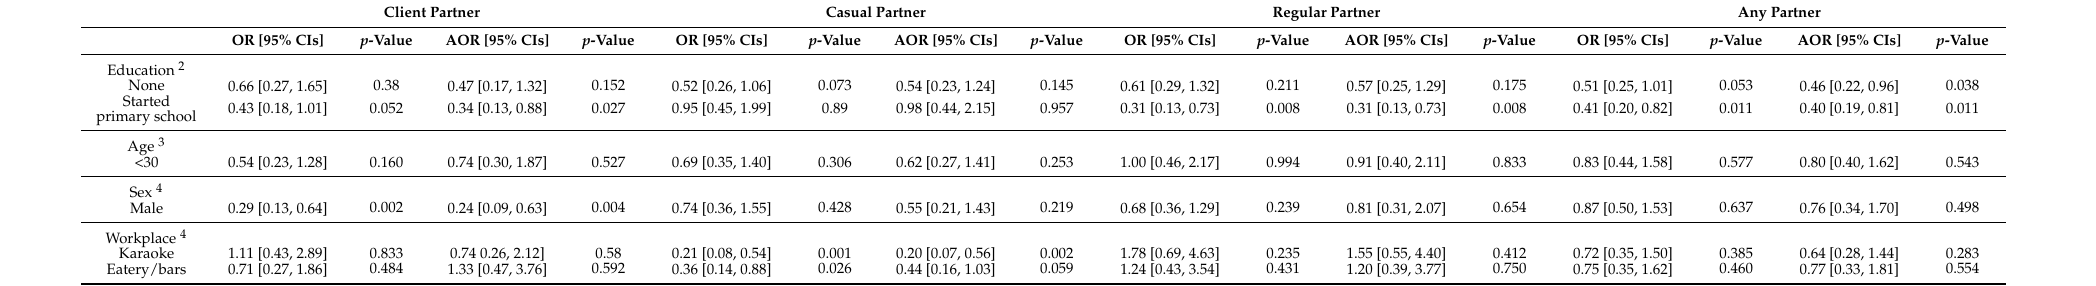
Table 3. Multivariate logistic regression of consistent condom use by education, age, sex, and workplace (stratified by partner type) 1 . ClientPartner CasualPartner RegularPartner